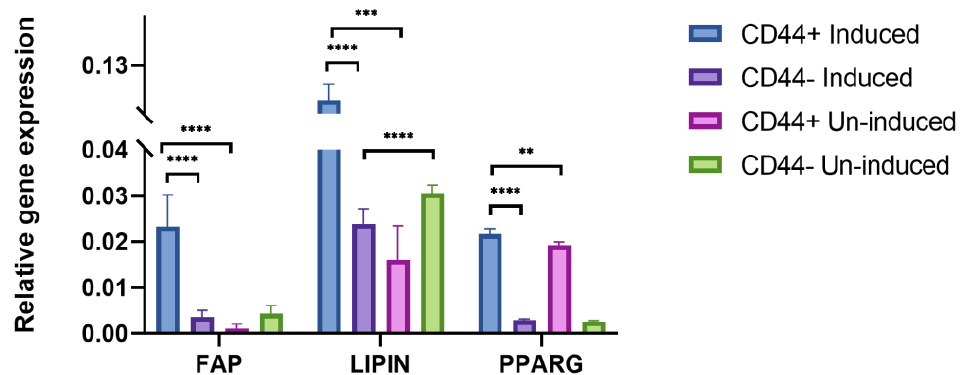
Figure 7. qPCR analysis of relative gene expression of adipogenic markers ( FAP , LIPIN , and PPARG ) after 21 days of adipo-induction. Un-induced cells grown in a complete growth medium, and induced cells grown in the osteogenic medium. CD44 + —CD44-positive cells, CD44 − —CD44-negative cells, ** p ≤ 0.01, *** p ≤ 0.001, and **** p ≤ 0 .0001.